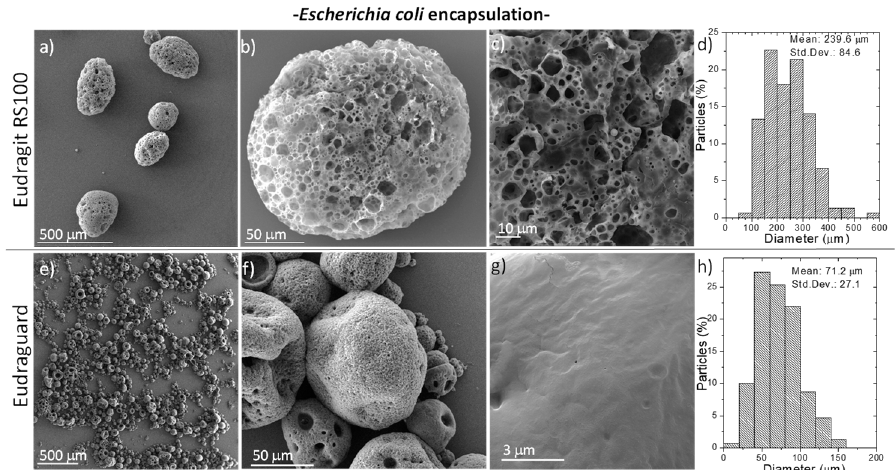
Figure 3. SEM micrographs ( a – c , e – g ) with different magnifications and particle size distribution histograms ( d , h ) (N = 150) of Eudragit RS 100 ( a – d ) and Eudraguard ( e – h ) microparticles loaded with Escherichia coli . Std. Dev. = Standard Deviation.